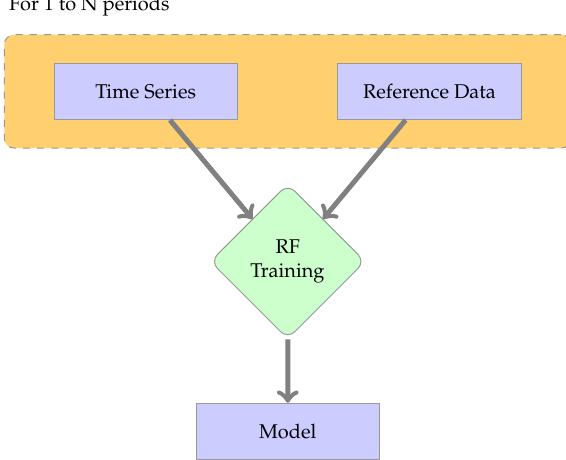
Figure 2. Workflow of the learning step.